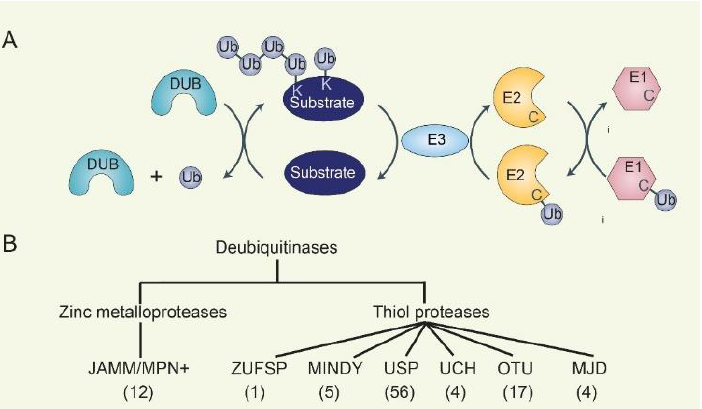
Figure 1. The cascades of ubiquitination/deubiquitination and families of DUBs. ( A ) E1, E2, and E3 cascades add mono- or polyubiquitin chains to substrates. DUB removes substrate-bound ubiquitin. ( B ) DUB contains seven subgroups: JAMM/MPN+, ZUSP, MINDY, USP, UCH, OTU, and MJD, depending on the characteristics of the conserved domains. The number of genes in each family is indicated.